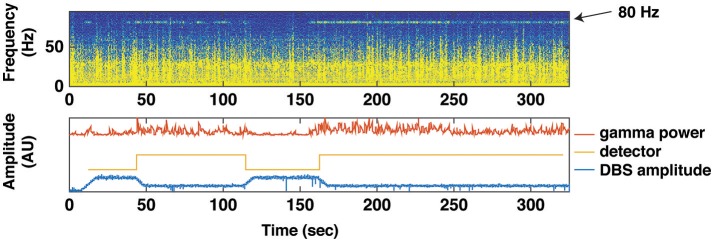
Using Gamma Power as a Biomarker for Closed Loop Deep Brain Stimulation. A brief trial of closed loop stimulation using a cortical detector in a patient with intermittent dyskinesia in spite of therapeutic STN DBS. This trial was implemented with data streaming from PC+S to an external computer (using Nexus D2/3). Top: spectrogram of motor cortex ECoG signal over 300 s, showing several epochs of an 80 Hz oscillation heralding the dyskinetic state. Bottom: transitions in stimulation triggered by the 80 Hz oscillation. Red line depicts the gamma power envelope at 80 Hz center frequency and 5 Hz bandwidth. Gold line depicts the detector that classifies gamma power to high or low values. Blue line depicts spectral power at stimulation frequency (160 Hz). When average gamma power (over 10 s) exceeded or dropped below a threshold (2.5 × standard deviation of gamma power during a calibration recording), stimulation was decreased, or increased, respectively.